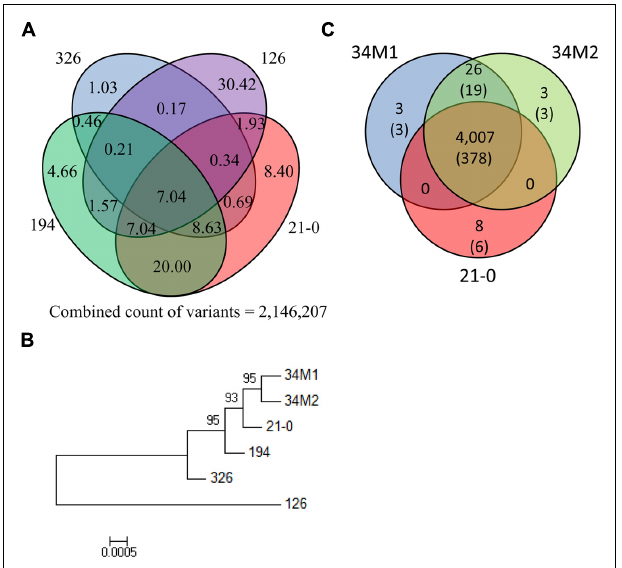
FIGURE 5 | Comparison ofAustralian Pgt isolate genome sequences. (A) Venn diagram showing the percentage of the total number of polymorphisms detected in the four Australian founder Pgt isolates (21-0, 126, 194, and 326) that are shared between different isolates. (B) Phylo- genetic tree of Australian Pgt isolates.This phylogeny was produced by FastTree from homozygous SNPs in the six stem rust isolates. Local bootstrap support values are shown.This tree is midpoint rooted. (C) Venn diagram showing numbers of shared non-synonymous polymorphisms in HSP genes between 21-0, 34M1 and 34M2. Figures in the parenthesis refer to the number of genes in which the polymorphisms